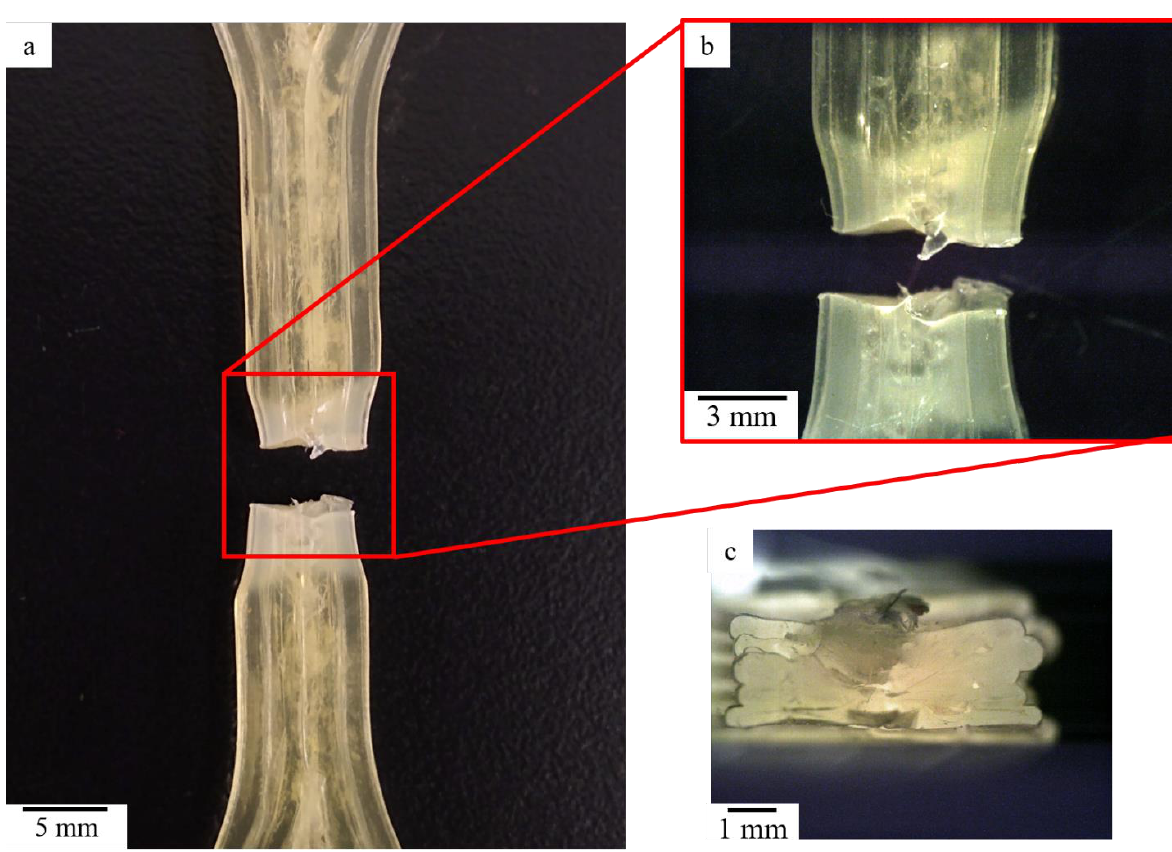
Figure 4. Optical microscope images taken of ( a ) fracture area of tested tensile specimen; ( b ) magnified view of fractured area; ( c ) cross-section of fractured area.